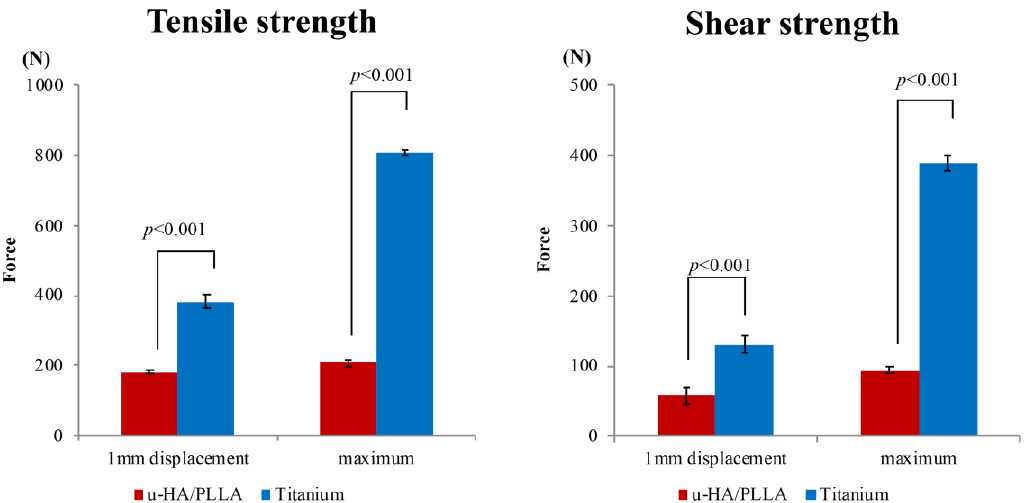
Figure 3. ( A ) Comparison of titanium plates and unsintered hydroxyapatite (u-HA) / poly- l -lactide (PLLA) bioresorbable plates with regard to maximum tensile test force and test force at 1 mm displacement in the tensile test. ( B ) Comparison of titanium plates and u-HA / PLLA bioresorbable plates with regard to maximum tensile test force and test force at 1 mm displacement in the shear test.